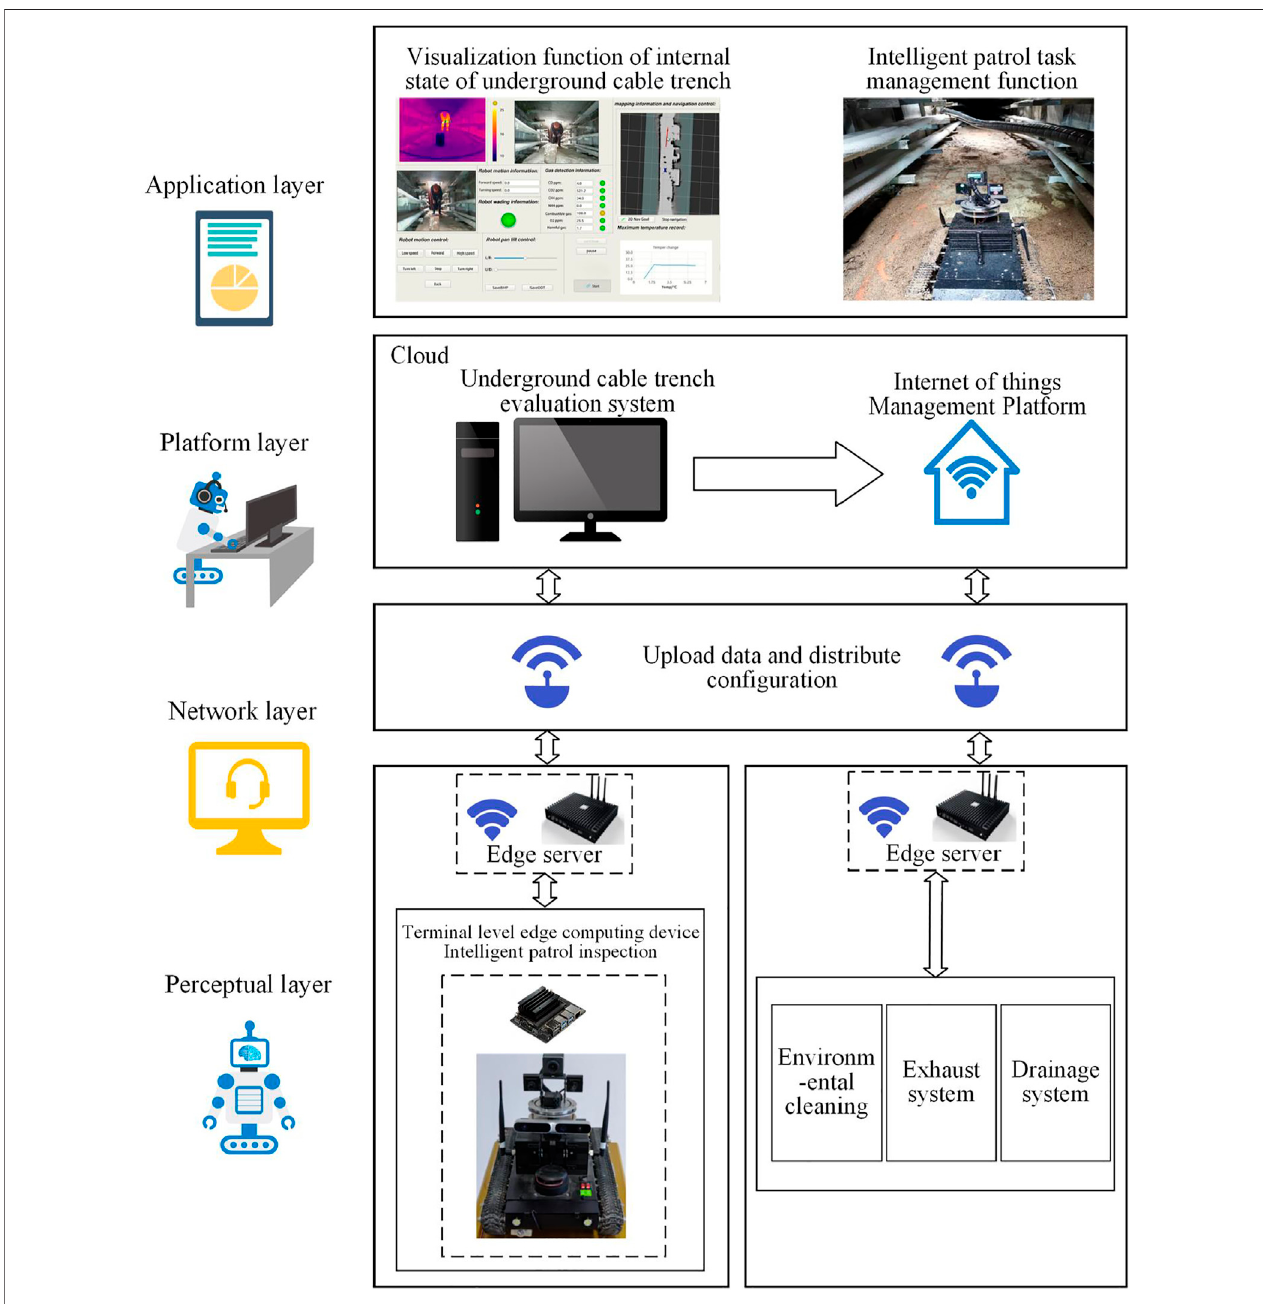
FIGURE 4 | Intelligent overall block diagram of the underground cable trench